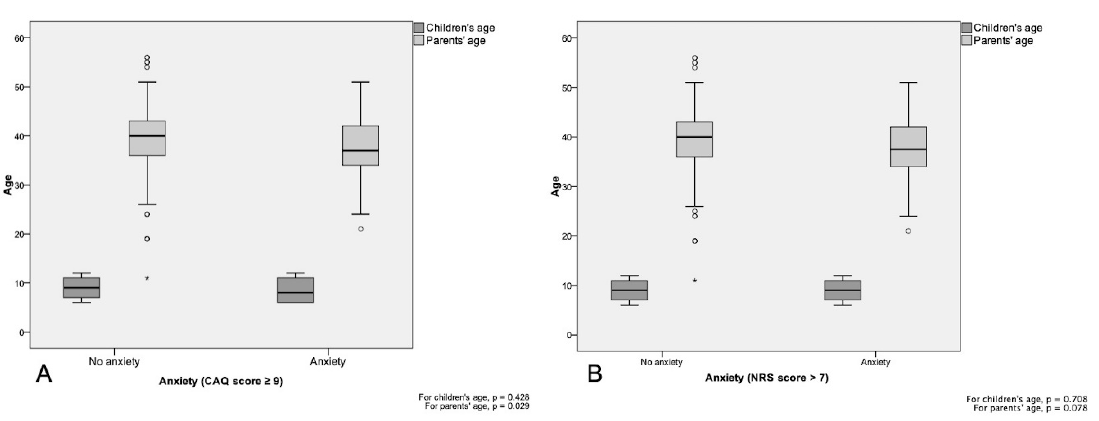
Figure 1. Comparison of children’s anxiety scores on CAQ ( A , B ), according to their guardians’ age. Mann–Whitney-U test for independent median comparisons.